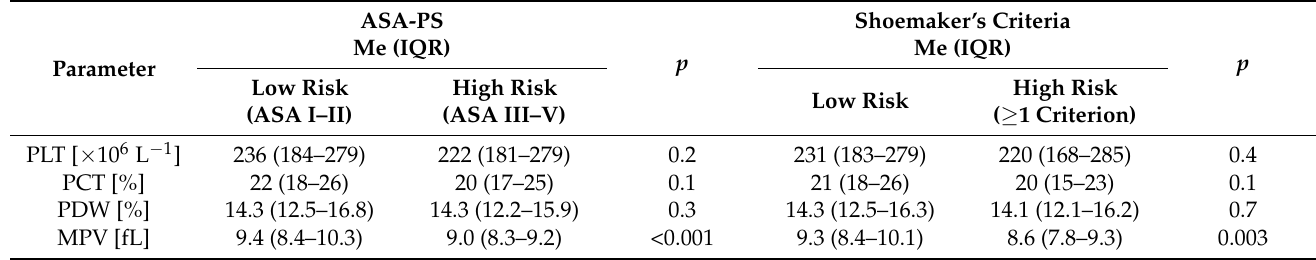
Table 5. PLT and MPV values, and individual risk according to ASA-PS and SC.